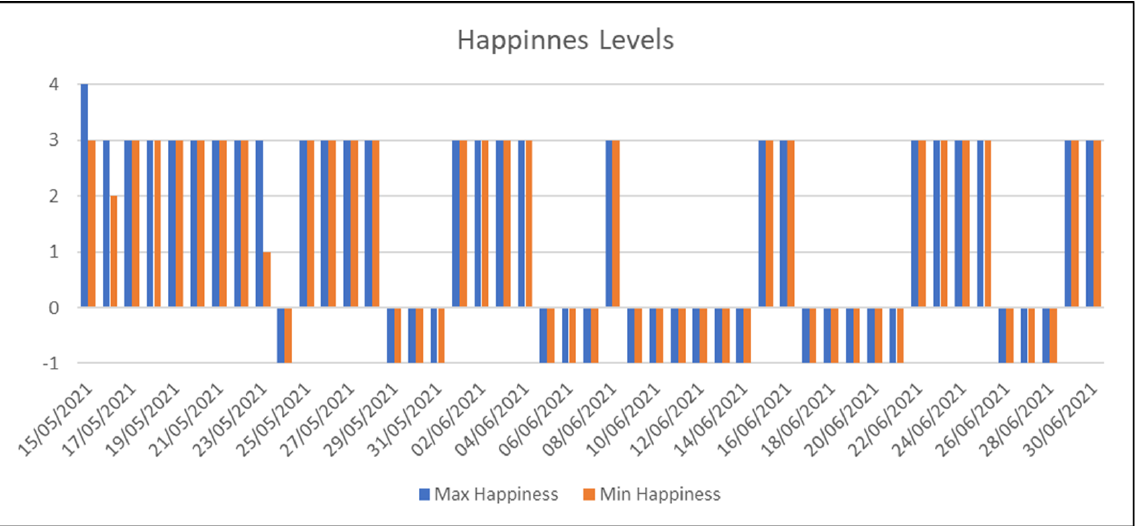
Figure 11. This figure shows the maximum and minimum happiness values recorded each day